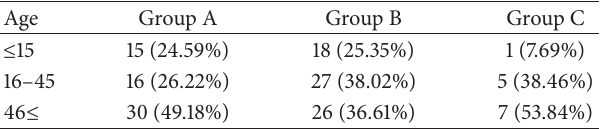
Table 1: The age distribution of groups A, B, and C.